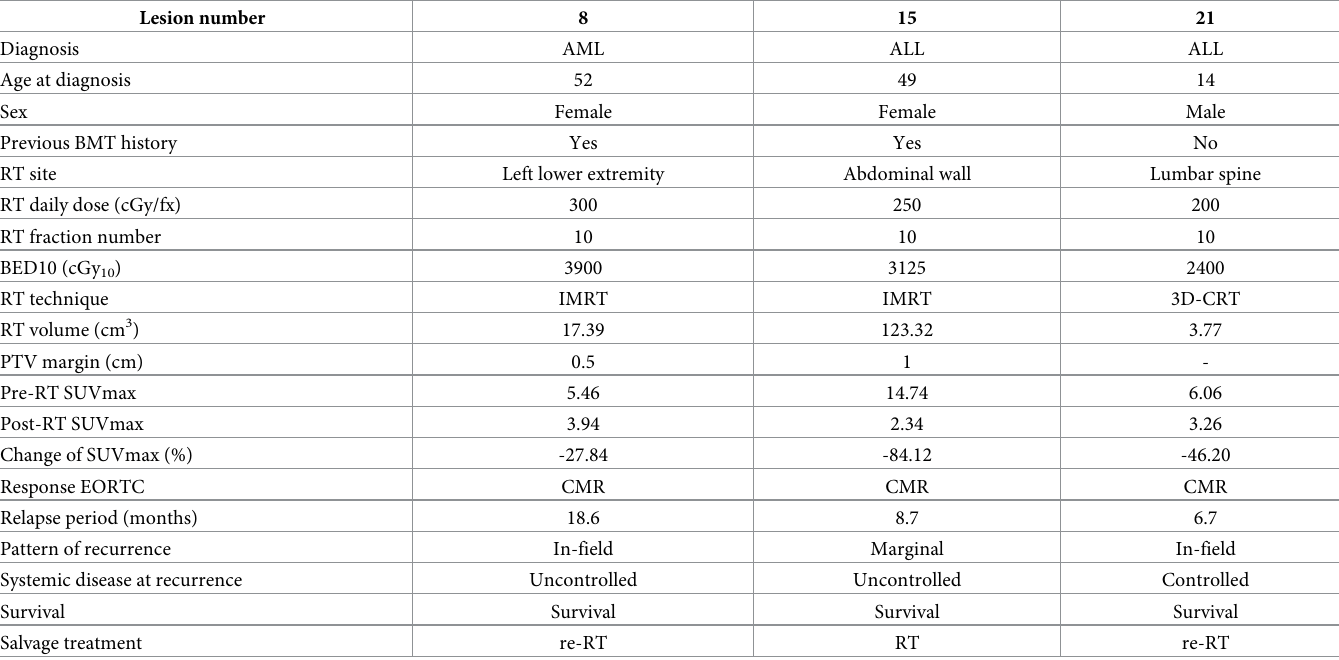
Table 4. Characteristics of recurrent lesions after